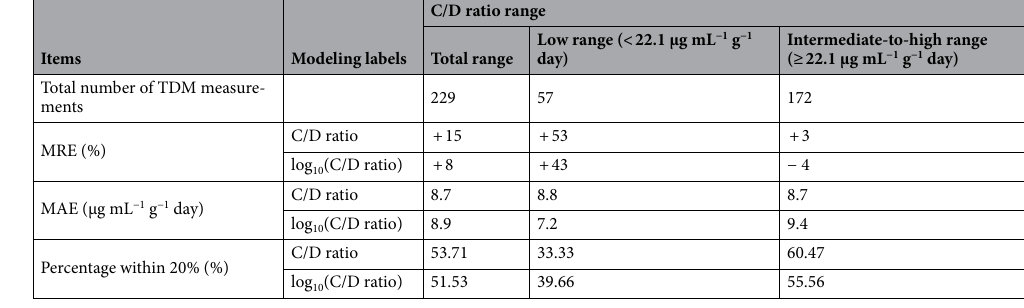
Table 5. The total number of therapeutic drug monitoring (TDM) measurements, mean relative error (MRE) (%), mean absolute error (MAE), and percentages of predictions within 20% of the observed dose-adjusted concentrations (C/D ratio) in the validation cohort depending for different ranges of the C/D ratio in the context of modeling it and log 10 (C/D ratio) when treated as labels, respectively.